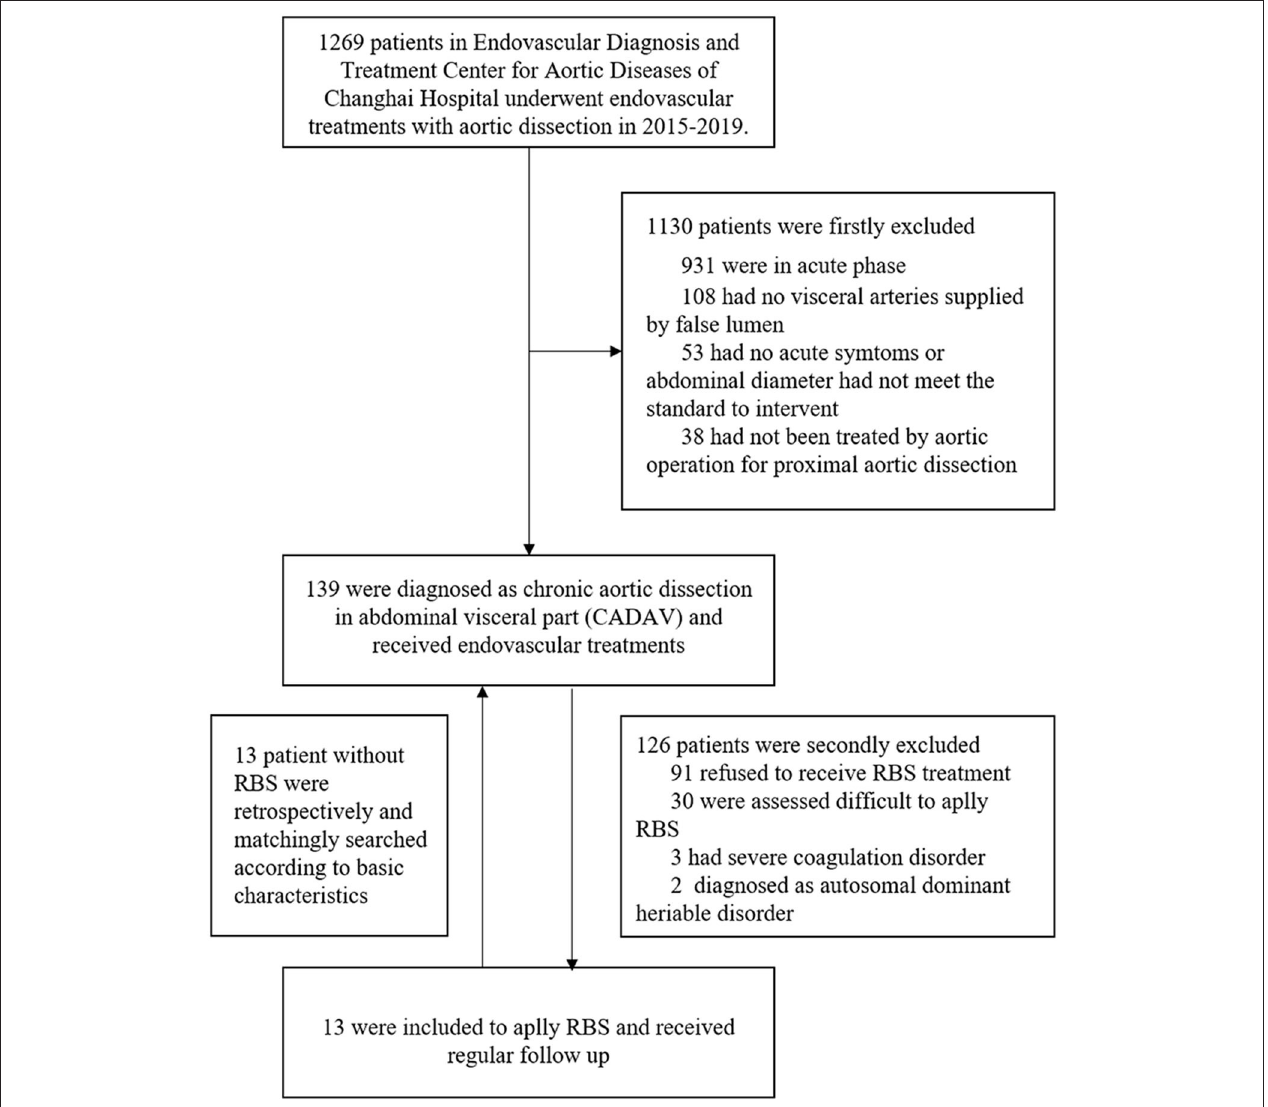
FIGURE 1 | Study population and inclusion/exclusion